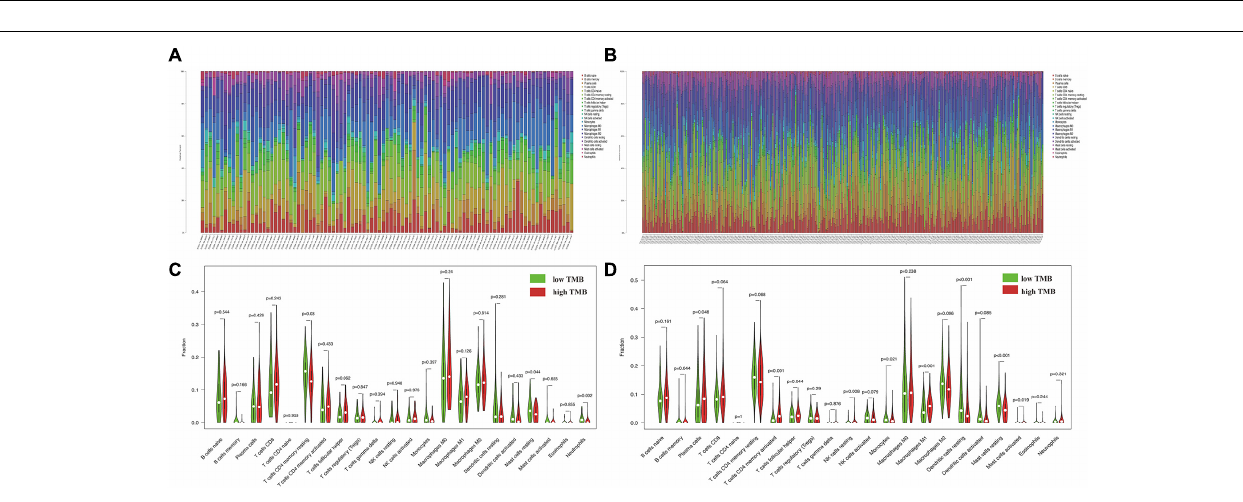
FIGURE 10 | Illustration of immune cell infiltrates features between low-TMB and high-TMB groups in each cluster. (A,B) The percent of 22 types of tumor-infiltrating immune cell in cluster 1 and cluster 2. (C,D) The difference of 22 types of immune cells between high and low TMB groups in cluster 1 and cluster 2. The higher TMB and lower TMB were shown in red and green. TMB, tumor mutation